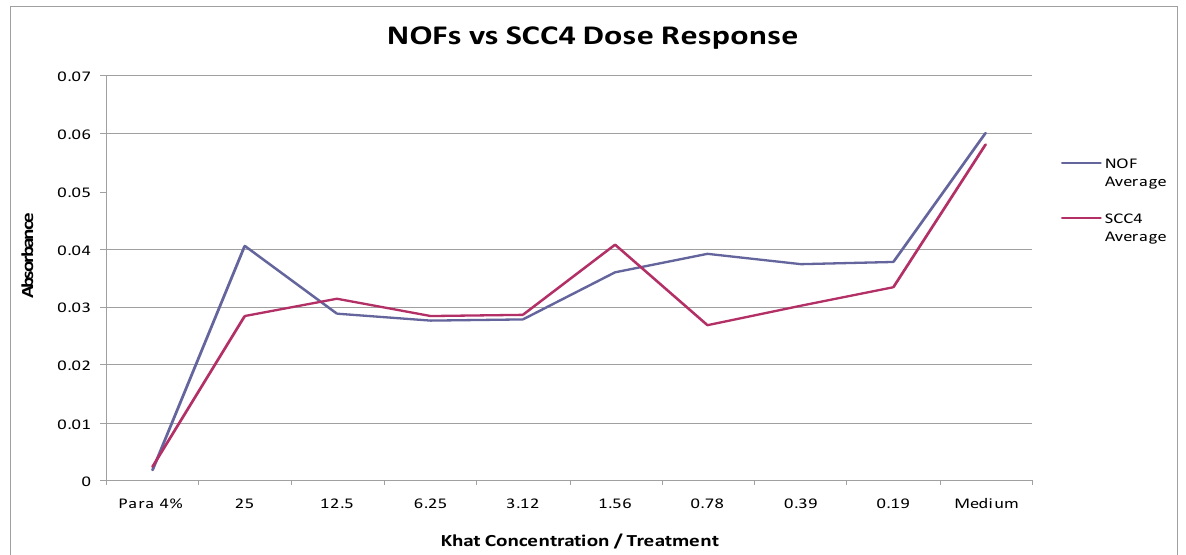
Figure 8. Comparison of dose response curves (MTT Assay) for NOFs and SCC4 cells treated with different concentrations of Khat solution (25 mg/mL to 0.195 mg/mL). Medium was used as a negative control while 4% paraformaldehyde acted as a positive control.